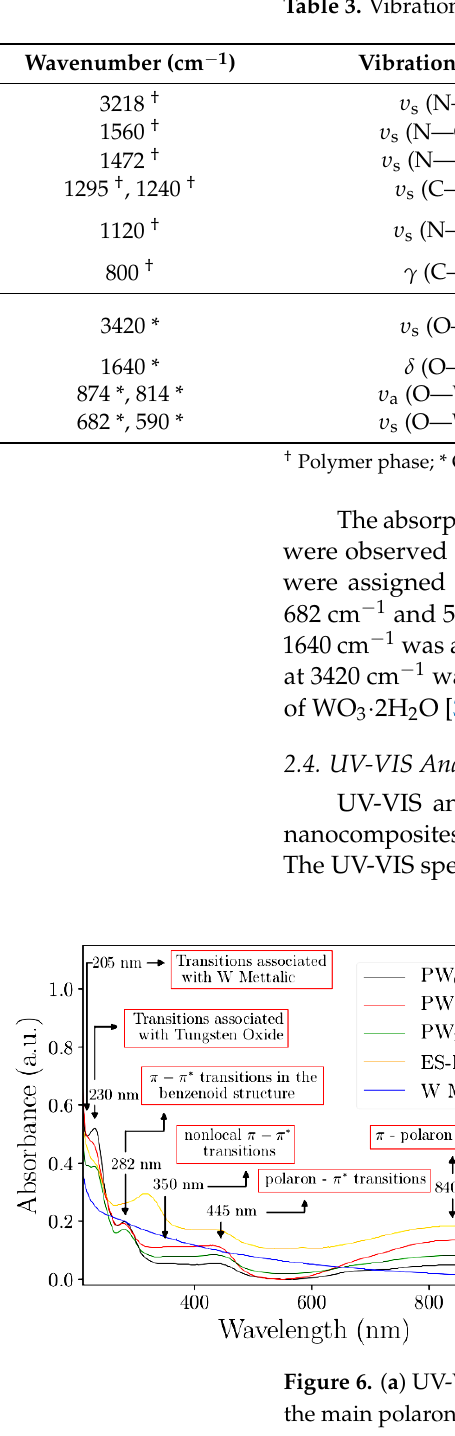
Table 3. Vibrational modes from the experimental FTIR spectrum of the nanocomposite phases.